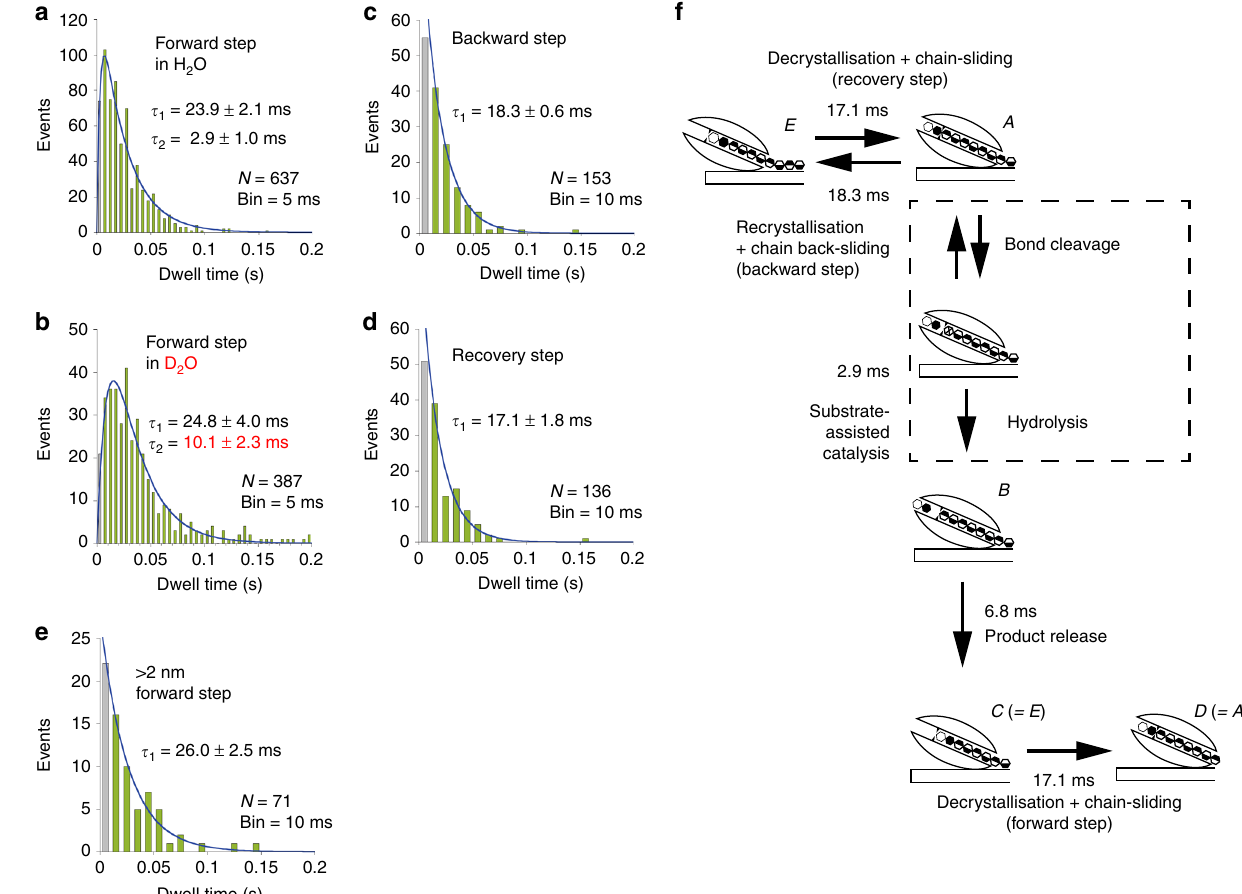
Fig. 3 Dwell time analysis of SmChiA movement. a , b Dwell time distributions before 1 nm forward steps in H 2 O ( a ) and D 2 O ( b ) fi tted by a model assuming consecutive reaction with two time constants (blue lines). c – e Dwell time distributions before backward ( c ), recovery ( d ), and before > 2 nm forward ( e ) steps fi tted by single exponential decays (blue lines). The values are obtained parameters ± fi tting errors. f Time constant summary of processive reaction cycle. Equilibrium constant between forward (state A ) and backward (state E ) stepped states is 1.1. Probabilities of substrate-assisted catalysis (86.3%) and backward step (13.7%) from state A are consistent with probabilities estimated by event number in Fig.